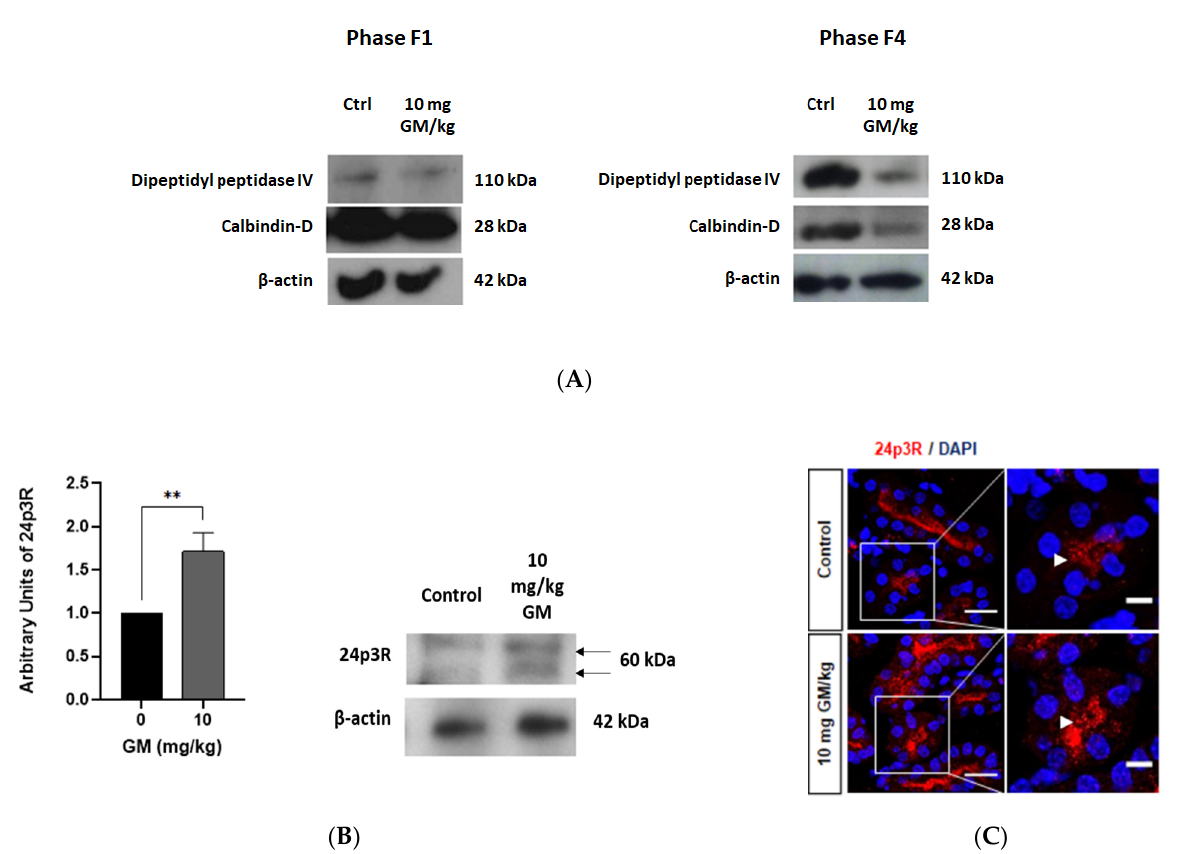
Figure 8. GM-induced PT injury is associated with increased 24p3R expression in DT. ( A ) Western blots of F1 (DT enriched) and F4 fractions (PT enriched) obtained after ultracentrifugation of tubules on a Percoll gradient. Dipeptidyl peptidase IV: PT marker; Calbindin-D: DT marker; ( B ) Representative blots of 24p3R and β -actin in DT enriched F1 fraction of untreated and GM-exposed mice (10 mg/kg). The bar chart shows means ± SD of normalized densitometry values. Student’s t -Test was performed. ** p < 0.05. n = 3. Each experiment was performed with 10 animals to obtain a pool of DT; ( C ) Representative micrographs showing the expression of 24p3R in renal tissue of control and GM-treated mice. Arrows show expression of 24p3R. Nuclei are stained with DAPI (blue). Scale Bars = 50 µm ( left ) and 20 µm ( right ).